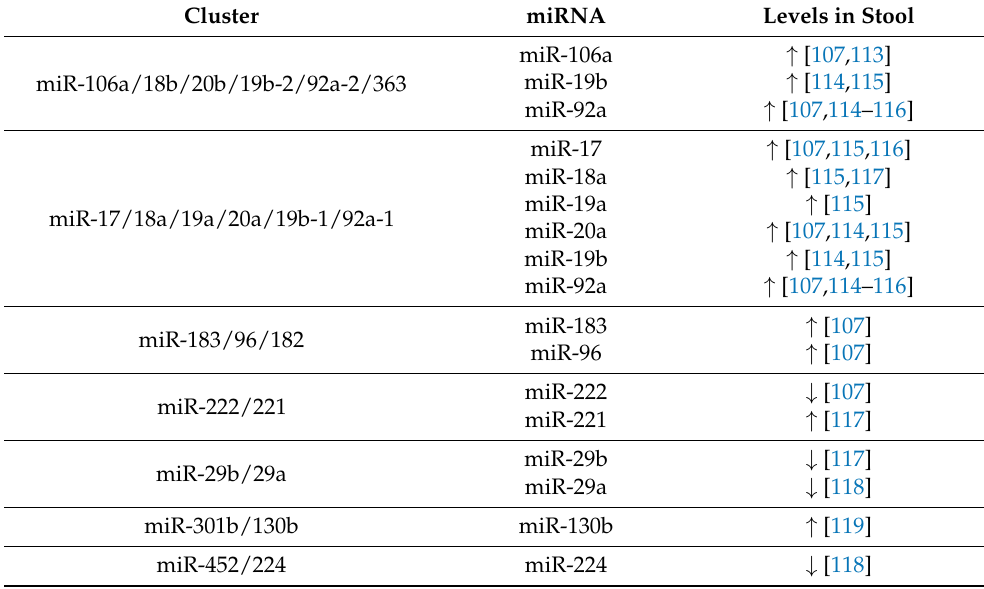
Table 4. Changes in miRNA expression in the stools of patients with CRC, compared with controls.